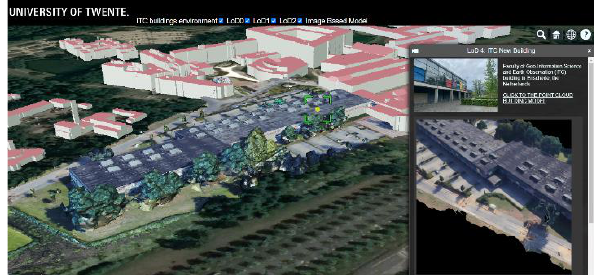
Figure 5 . The popup link that connects the 3D WebGIS Globe with the VR environment of the new ITC building.